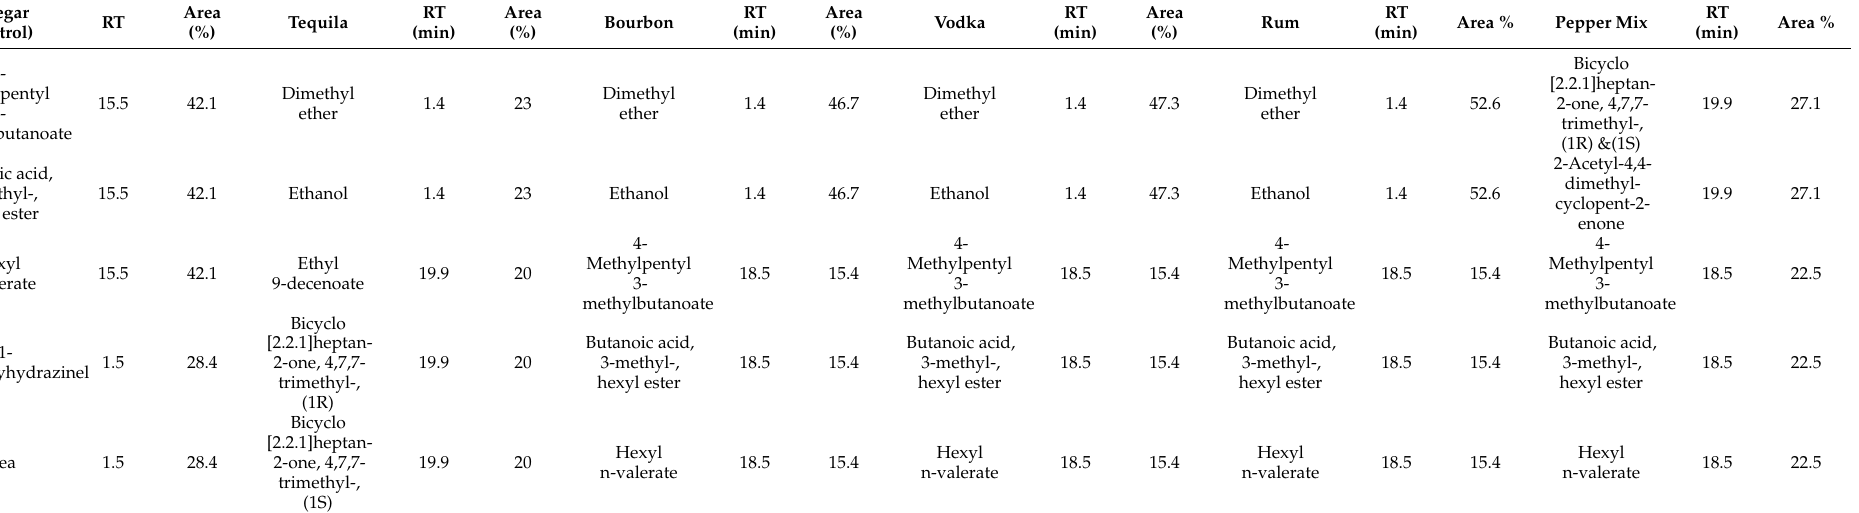
Table 1. Major volatile compounds detected in hot sauces